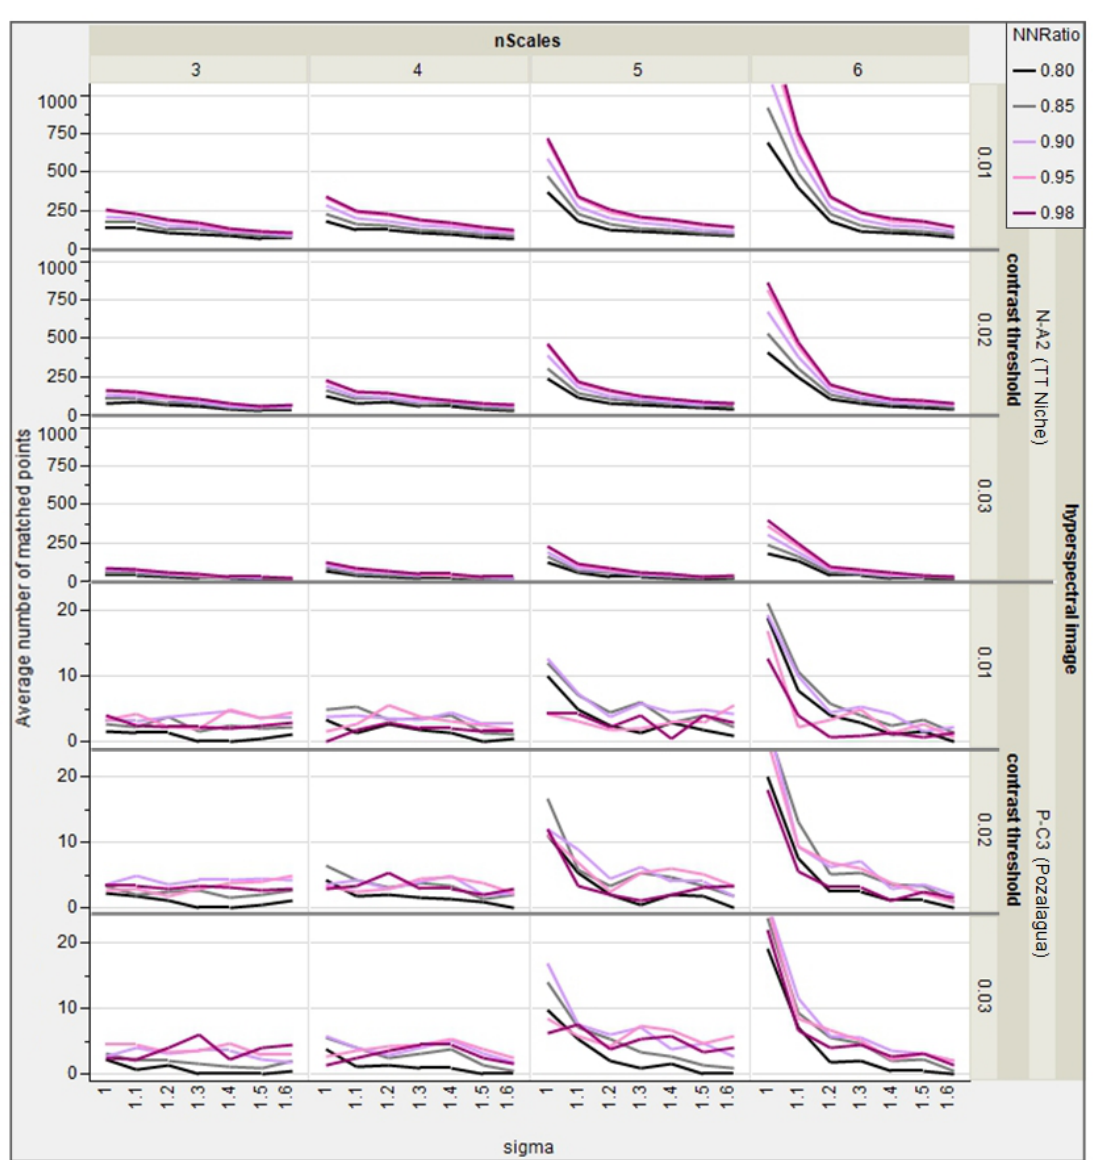
Figure 9. Average number of points matched for a single hyperspectral band, showing influence of all the tested parameters for N-A2 (TT Niche top three rows) and P-C3 (Pozalagua quarry, bottom three rows). Note different scales on left vertical